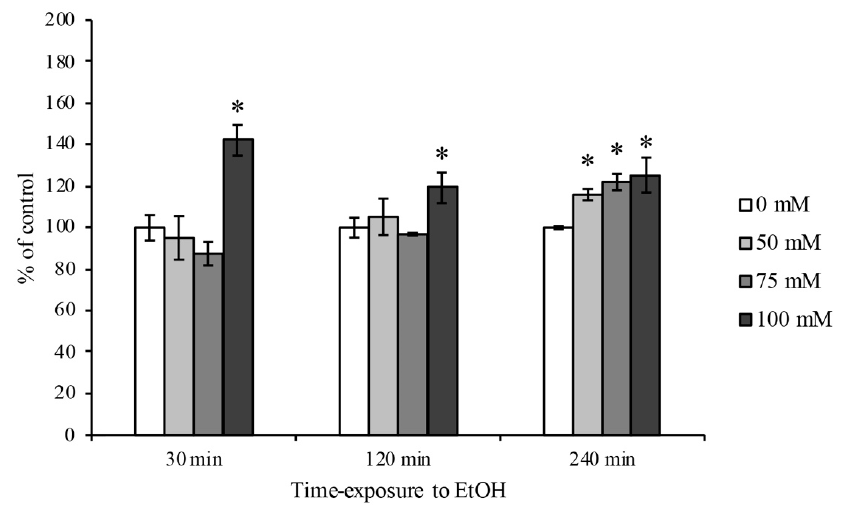
Figure 2. ROS quantification on RBE4 cells after EtOH treatment. Representative ROS production